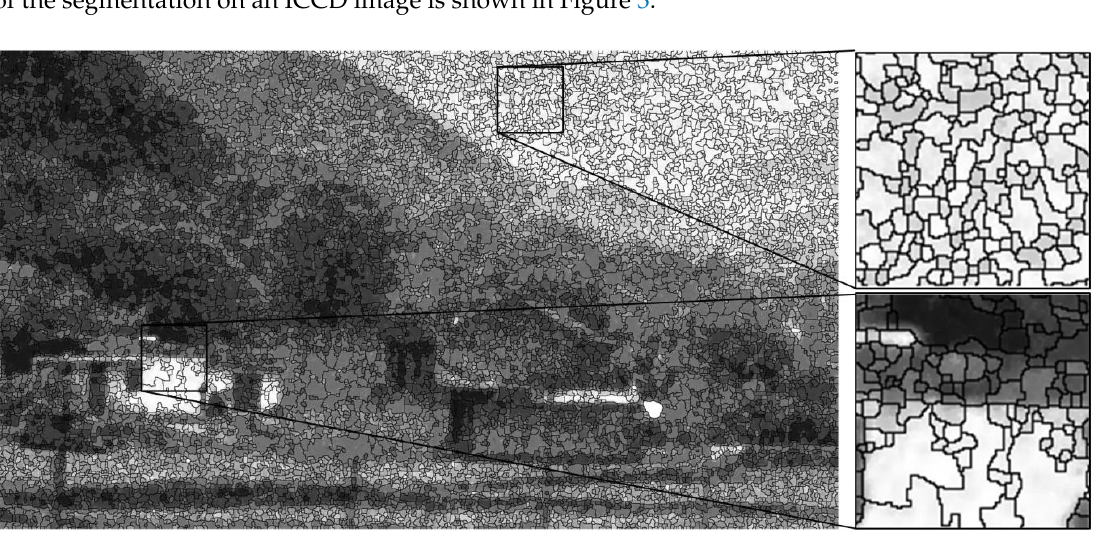
Figure 3. The segmentation result with watershed algorithm on an ICCD image.